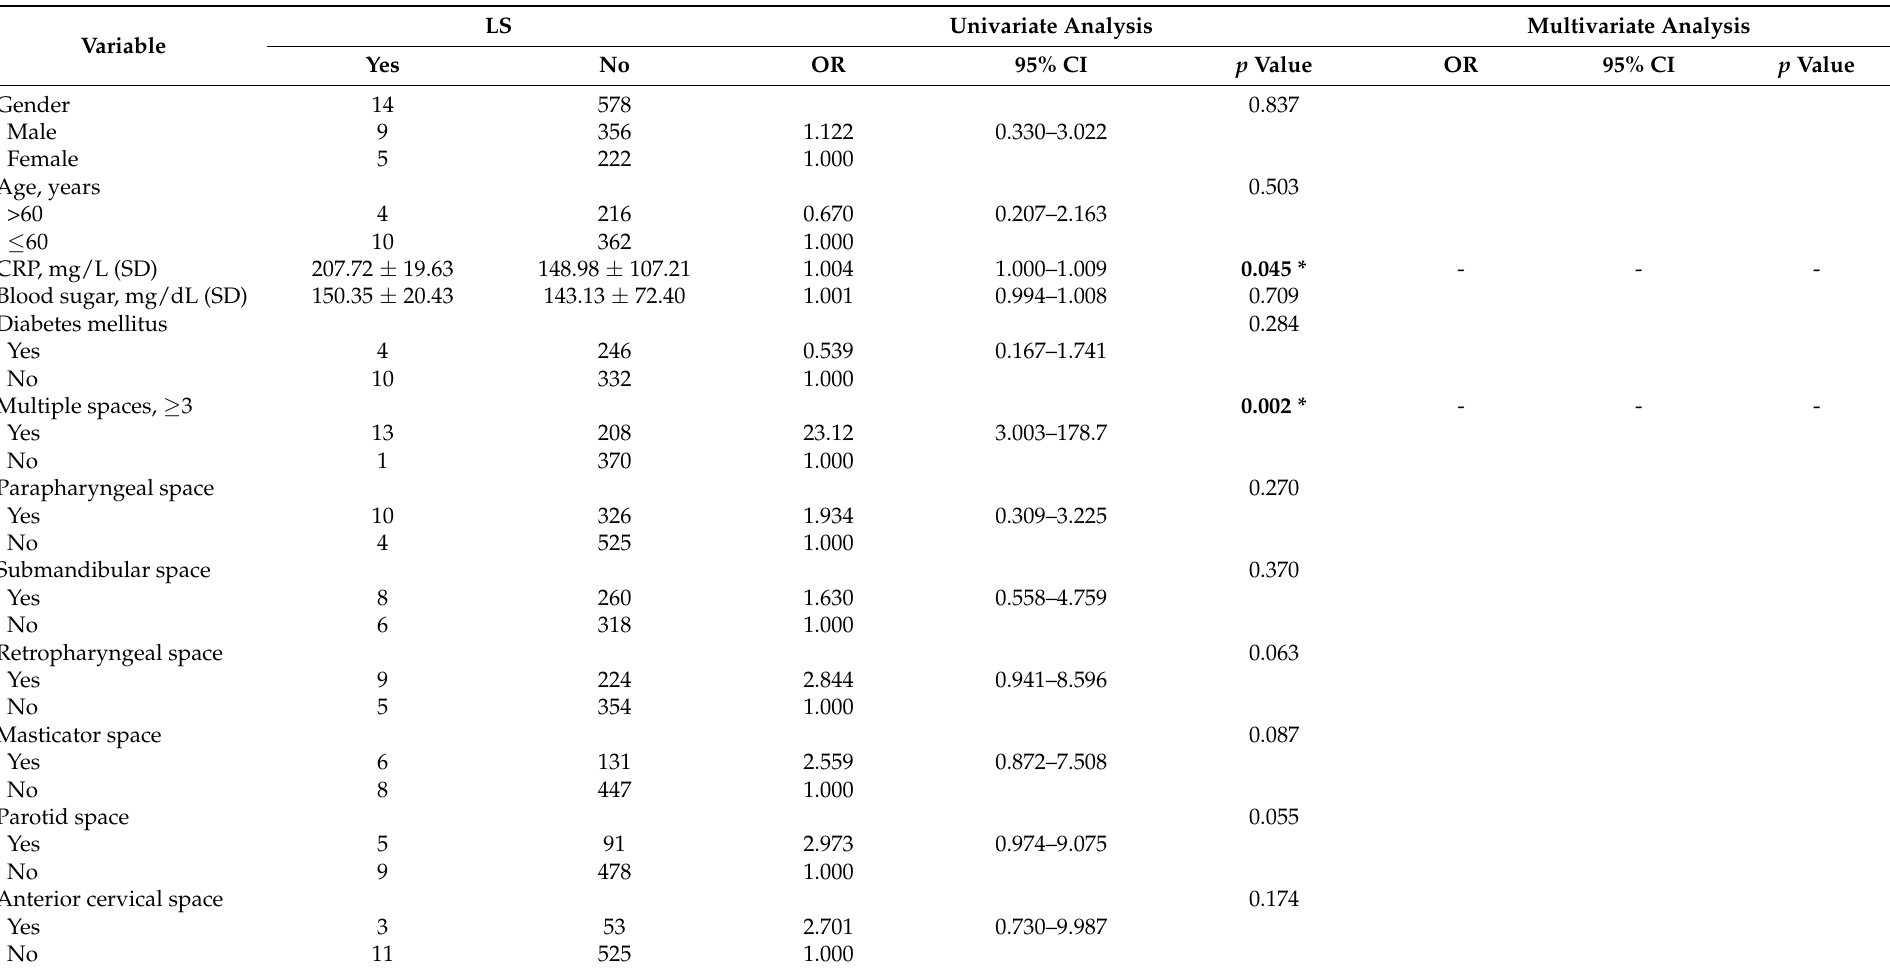
Table 2. Univariate and multivariate analyses of data from 14 patients with concurrent DNI and LS compared with those from 578 patients with DNI